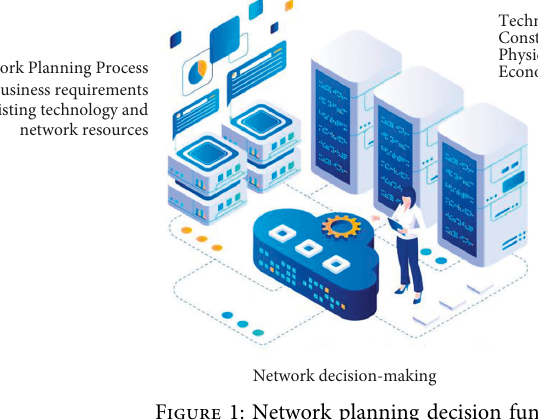
Figure 1: Network planning decision function.